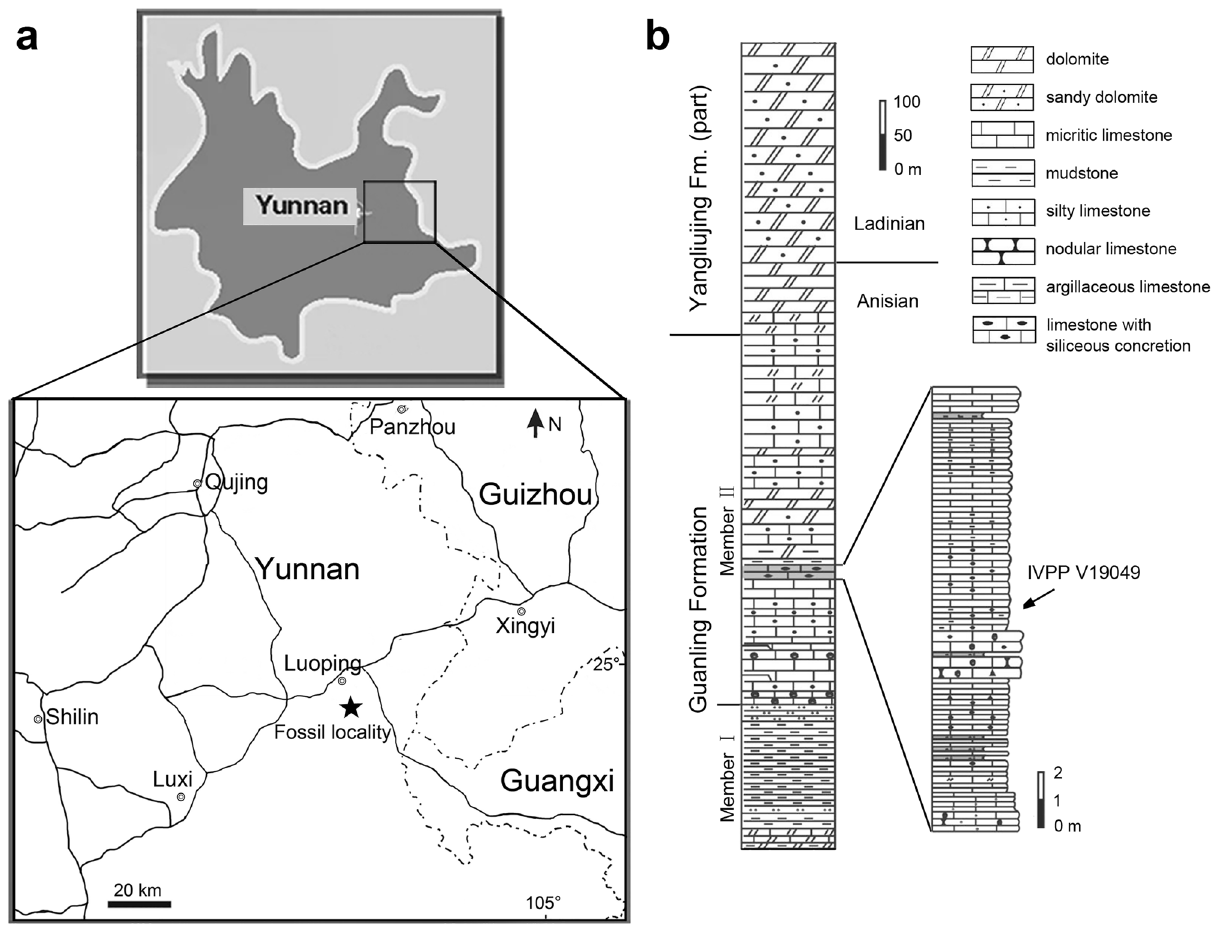
Figure 1. Locality map and stratigraphic section. The fossil locality in Luoping, eastern Yunnan ( a ) is indicated by a star, and the stratigraphic section in Luoping ( b ) is modified from ref 33